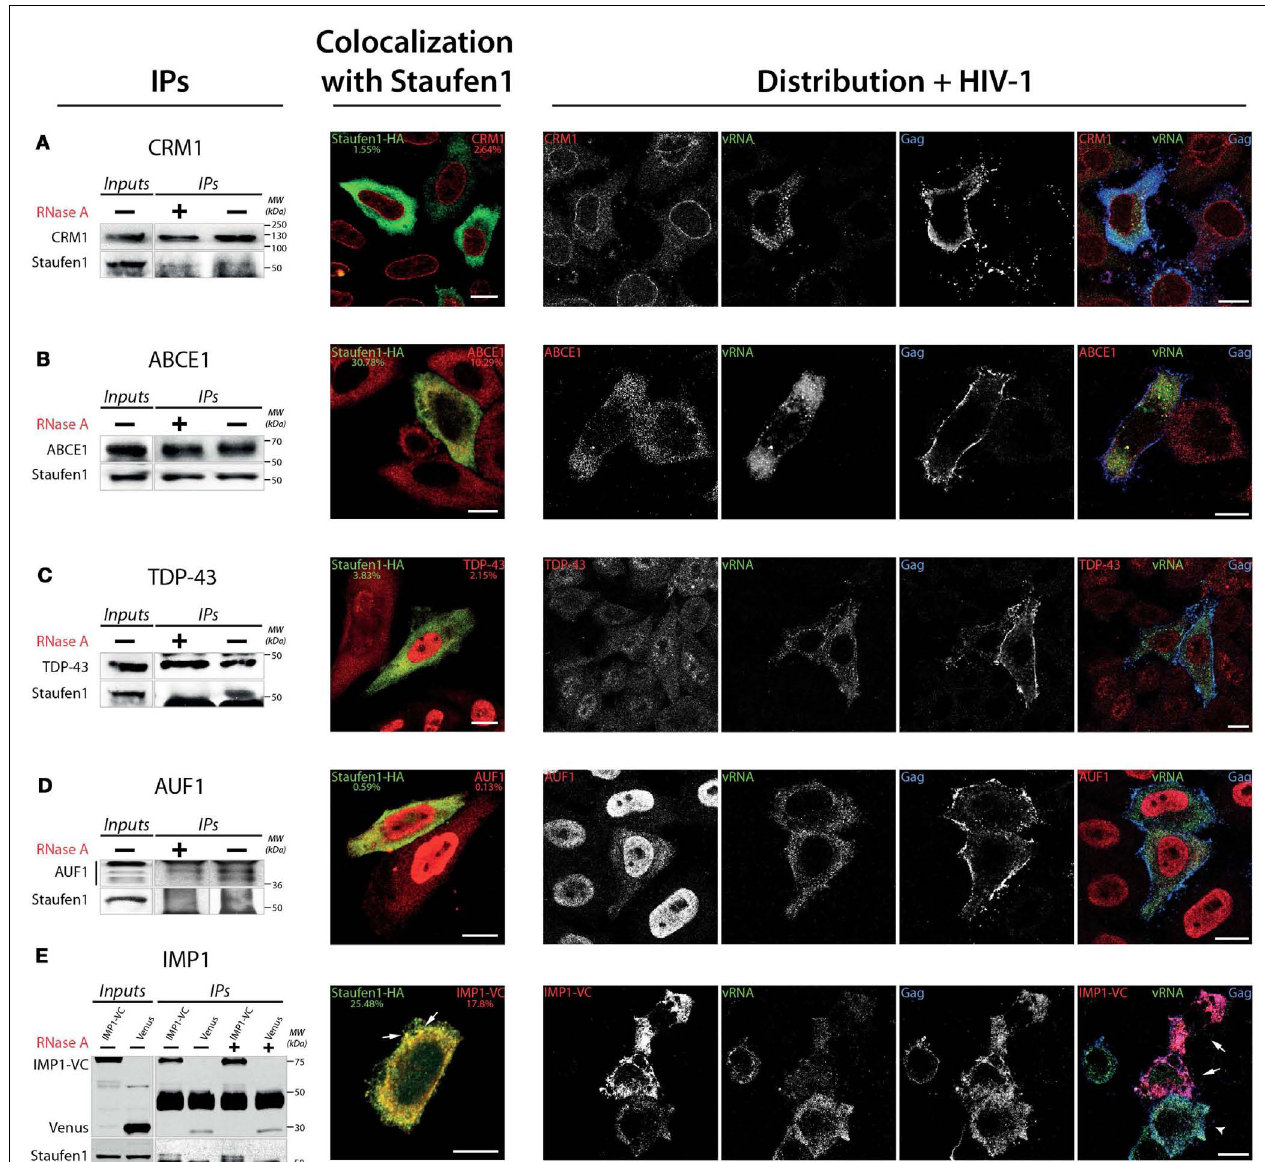
(ABCE1), AUF1,TAR DNA-binding protein (TDP-43) and IMP1 with Staufen1-HA.The Manders’ coefficients (average from > 10 cells per experiment derived from Staufen-HA expressing cells only, in %) are shown to provide an estimate of the co-localization. At the far right, the distribution of each host protein (in red) is shown in relation to Gag (blue) and the viral genomic RNA (vRNA, green) in HIV-1-expressing cells as determined by laser scanning confocal microscopy. Cells overexpressing IMP1-VenusC are indicated with white arrows in (E) . Size bars are 10 µ